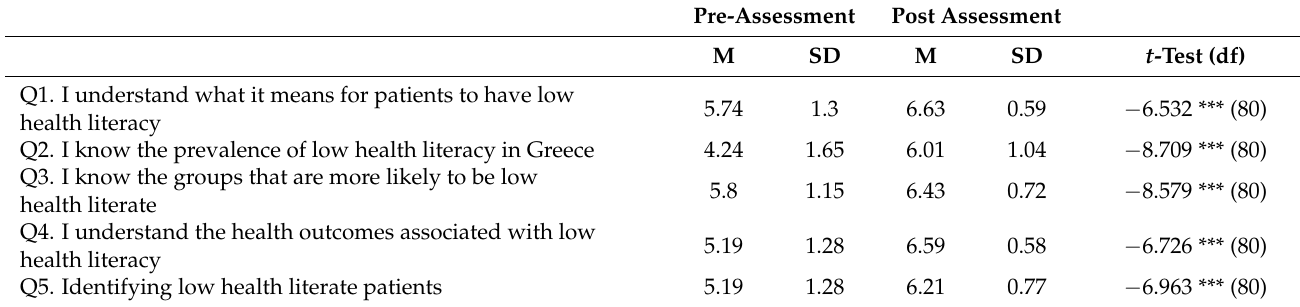
Table 3. Mackert’s interview items ( n =